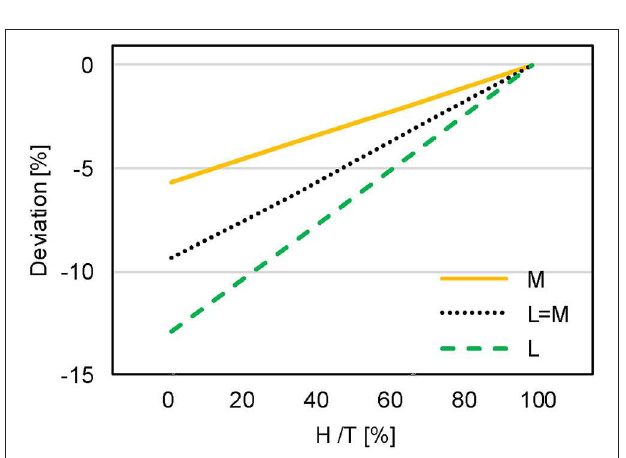
FIGURE 4 | Lines of equal deviation (from − 10 to − 50%) of the annual cooling demand from the benchmark, depending on the fraction of H, and M in total population. Reproduced from Mahdavi et al. (2018) with permission from A. Mahdavi, M. Taheri, and F.